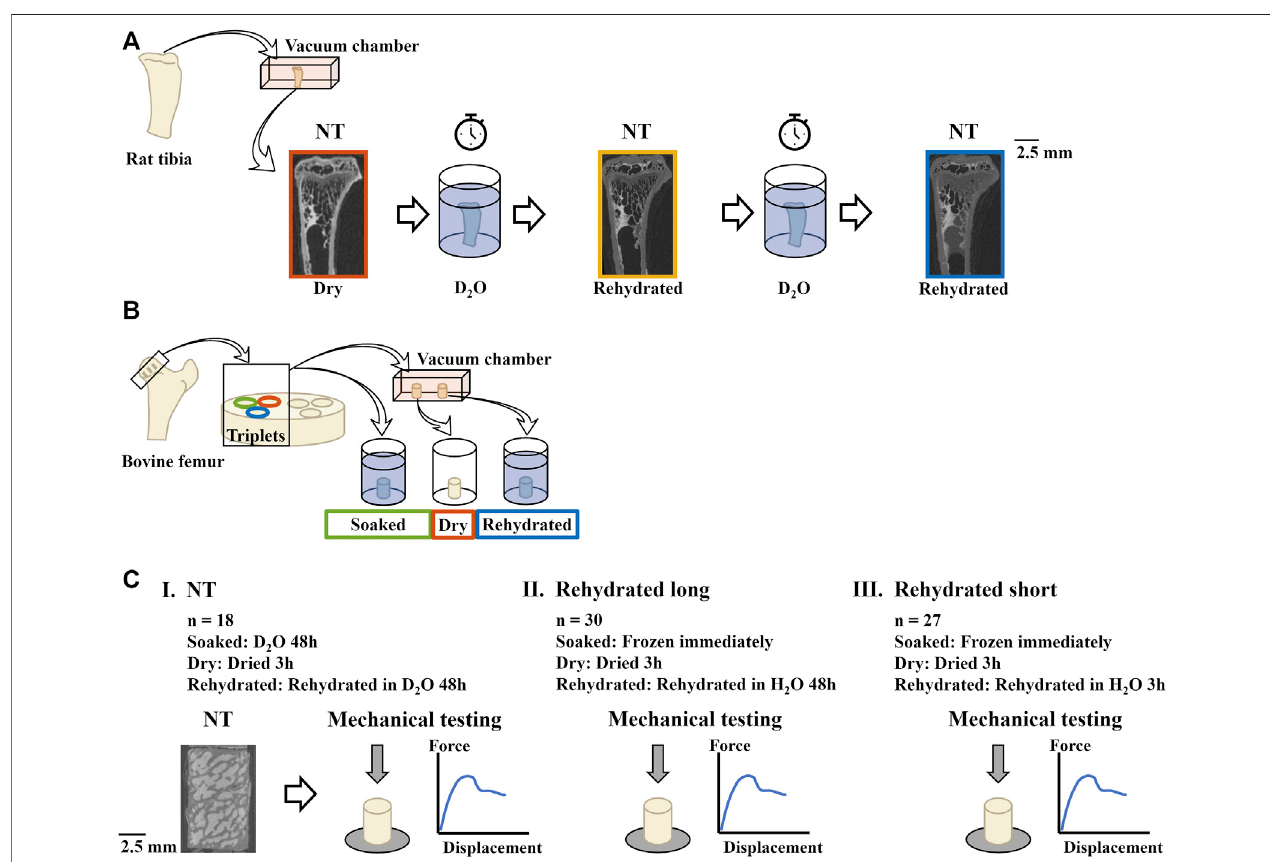
FIGURE 2 | Overview of the experimental procedure. (A) Proximal rat tibiae ( n = 3) were dried in vacuum before being imaged with neutron tomography (NT). The tibiae were then rehydrated in D 2 O and imaged again. Two of the specimens were further hydrated and imaged a third time. (B) Trabecular bone plugs ( n = 75) were extractedfrombovinefemora.Triplets(plugsextractednexttoeachother)weredividedintothreegroupswhichweresubjectedtothreedifferenthydrationprotocols. (C) Overview ofthe experimental campaigns. (I) 18plugs ( n = 6per hydration group) were imaged withNT before being mechanically tested in compression toassess mechanical properties. (II) 30 plugs ( n = 10 per hydration group) were mechanically tested. (III) 27 plugs ( n = 9 per hydration group) were mechanically tested. Note the differences in rehydration duration between (II) and (III)